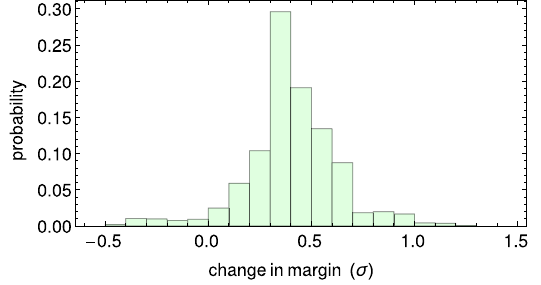
10. Change of margin due to orbit movements between the horizontal TCT in IR5 B2 and the aperture bottleneck in triplet (bottom) as calculated by Eq. (B4). All running periods from 2011 with stable beams and β (cid:1) ¼ 1 m were accounted for, except where large luminosity scans were performed. The orbits were sampled every 10